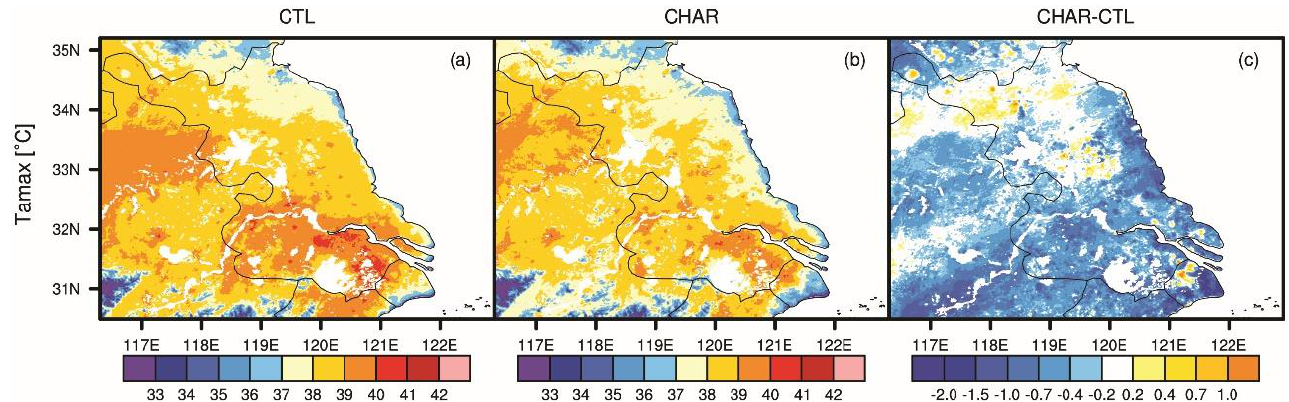
Figure 7. ( a ) Hourly variations of area-averaged observed and simulated air temperature, and ( b ) their difference (unit: °C) over the research period in EC.